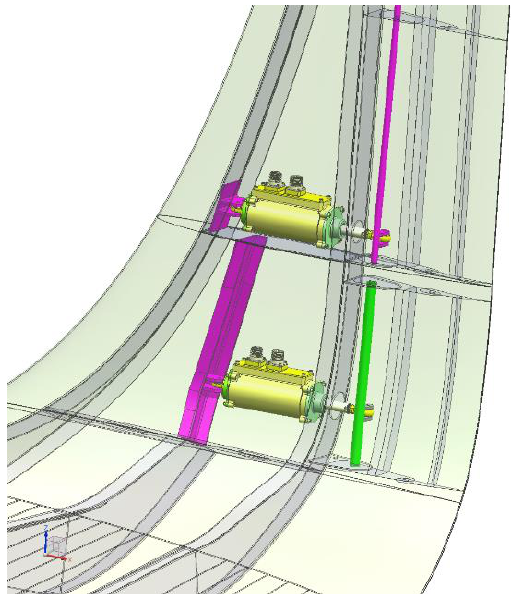
Figure 6. Non-concentric shaft layout of the actuators.